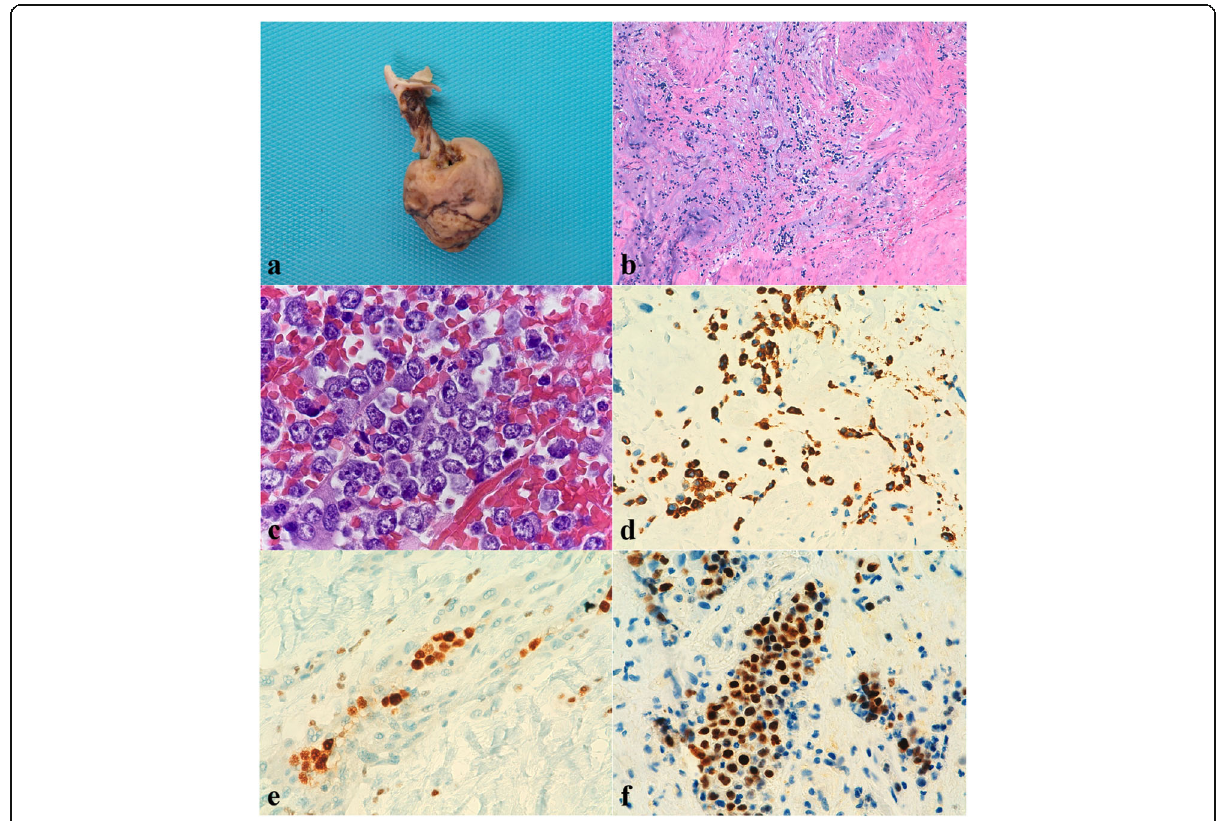
Fig. 1 a Macroscopic view of 3.5 × 3 cm solid, brownish polypoid specimen with a 2.3 × 0.7 cm pedicle. b HE (20x). Histological study revealed a proliferation composed of a dense eosinophilic substance with myxoid basophilic areas, in which spindle and starry cells were observed. No atypia or mitotic figures were identified. c HE (100x on oil). Within the myxoma, small aggregates of lymphoid-like cells were identified. High magnification showed vesicular nuclei and conspicuous nucleoli with several mitotic figures and nuclear debris. d CD79 (40x). Lymphoma cells were positive for CD79. e OCT2 (40x). Lymphoma cells were positive for OCT2. f MUM1 (40x). Lymphoma cells showed non-germinal